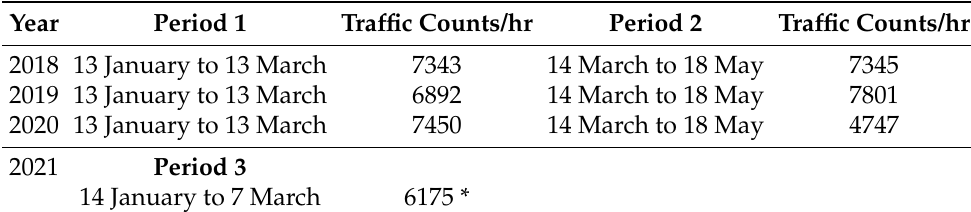
Table 2. Dates for Period 1, Period 2, and Period 3 defined in this study. Numbers in the traffic columns are the average afternoon traffic counts per hour at three traffic measurement sites in downtown Toronto. The average traffic counts here is only from 14 January to 18 February 2021, due to the availability of traffic data. Details of the traffic measurement sites are included in Section